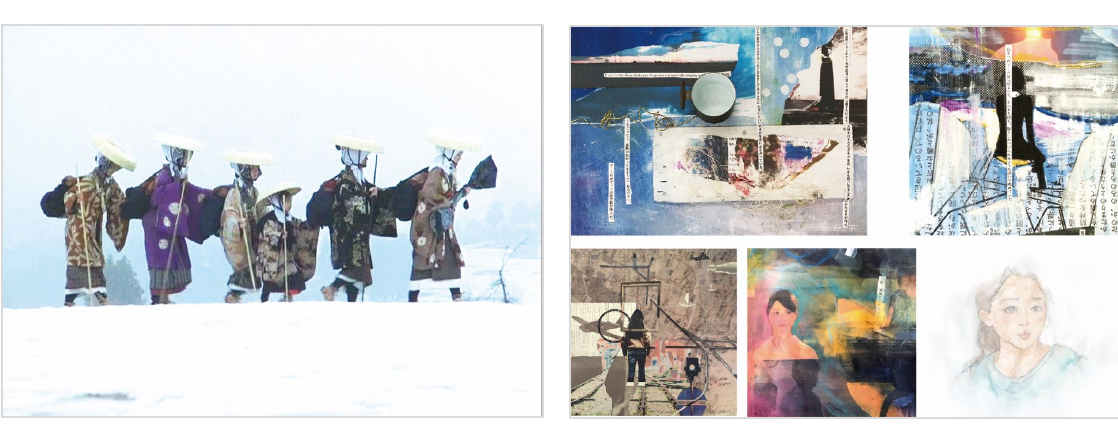
Figure 28 Blind female minstrels of the mutual aid organization. From Ballad of Orin .